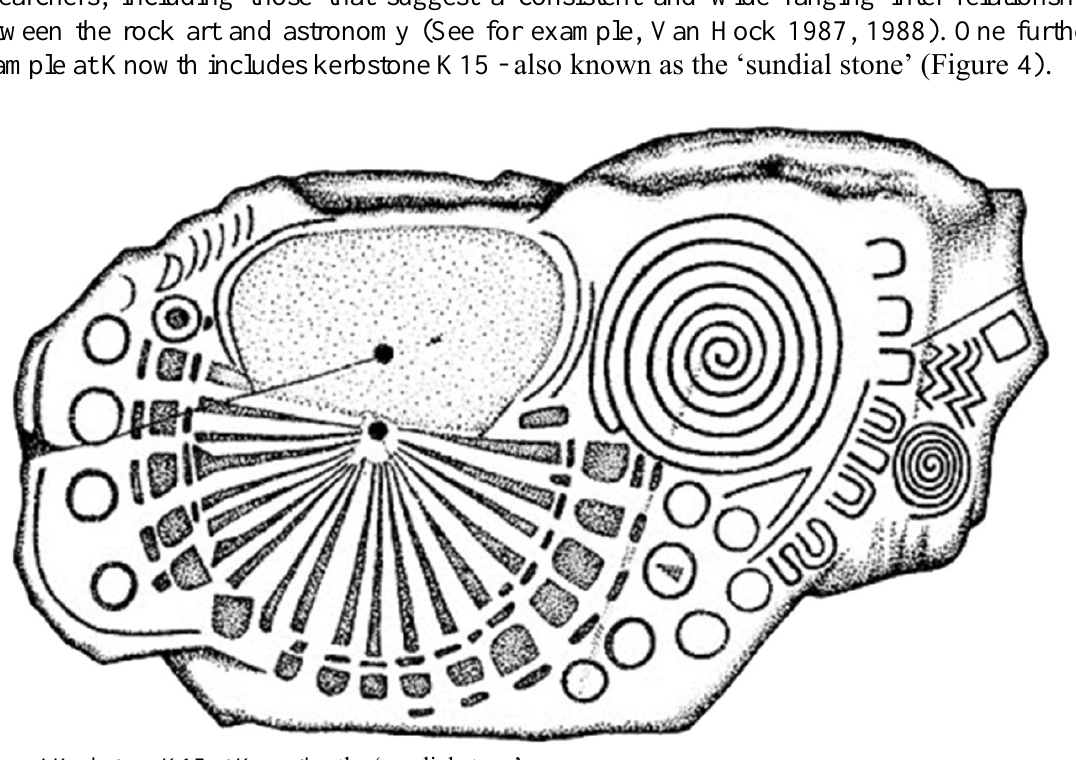
Figure 4 Kerbstone K15 at Knowth - the ‘sundial